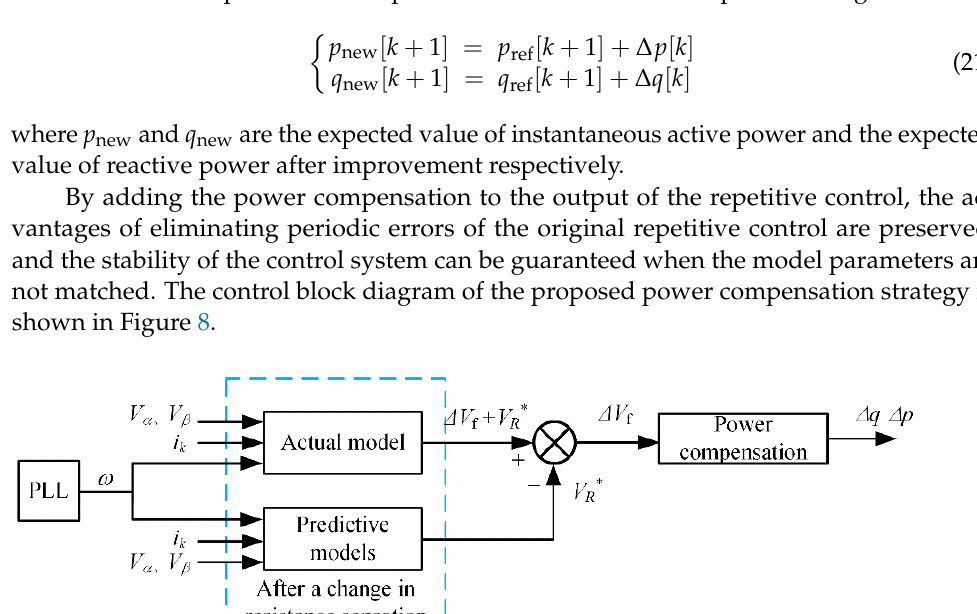
Figure 7. PWM Rectifier Single-Phase System Model: ( a ) Ideal single-phase system model. ( b ) Ac- tual single-phase system model.